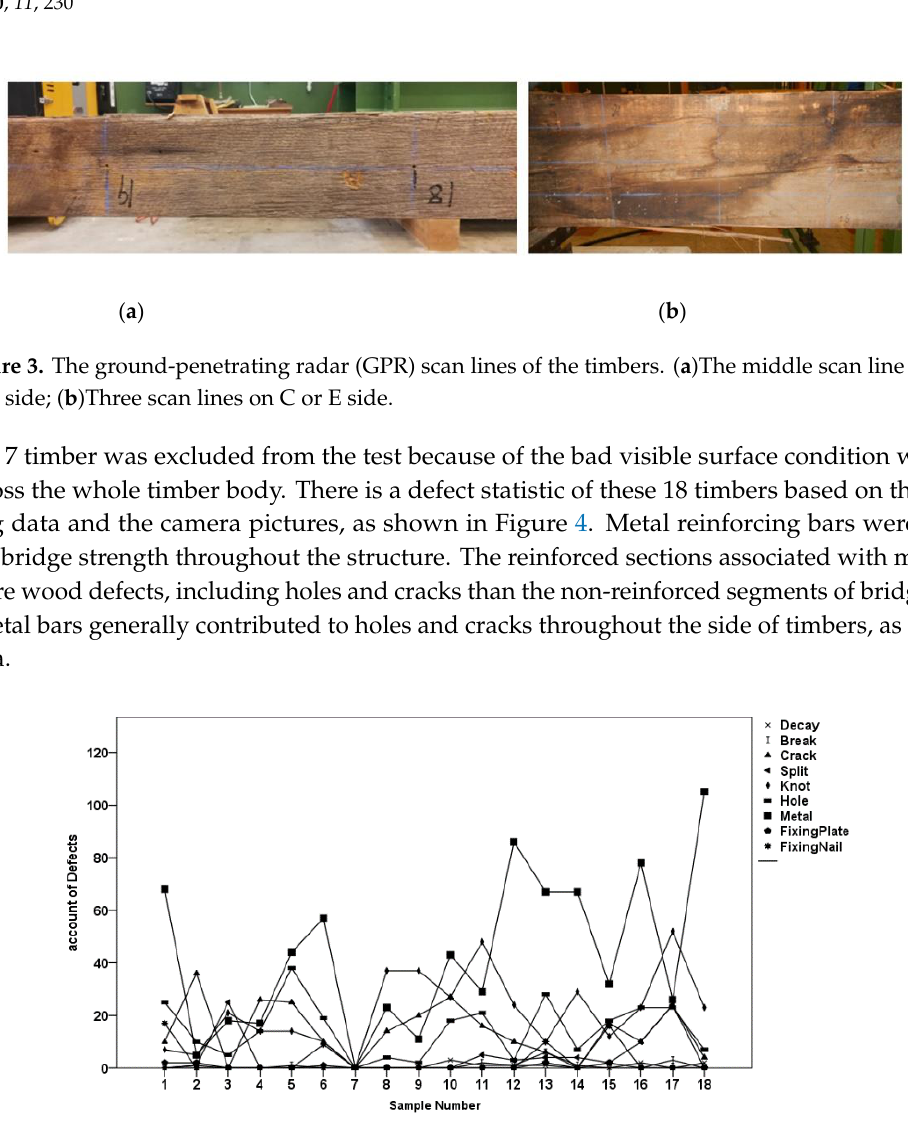
represent the bottom and top sides with 381 mm width, B and D denote the front and back sides with